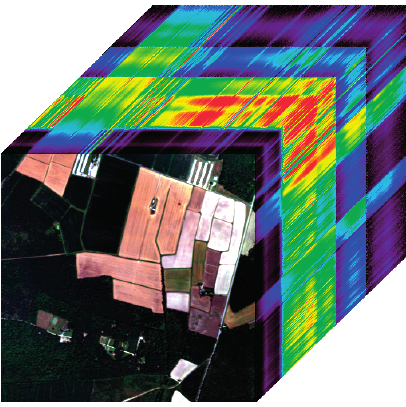
Figure 5. 3D cube of the AVIRIS dataset cover a farmland area of 320 × 320 pixels with 193 spectral